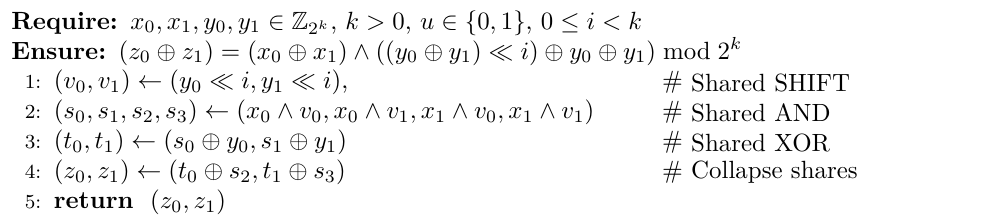
Algorithm 6 2-Share TI of a k -radix AND-XOR-SHIFT gate ( SecAndShiftXor